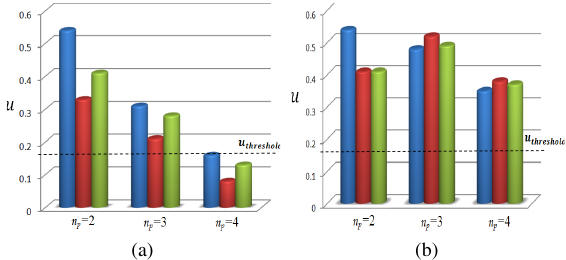
Figure 4: shows the uncertainty u variation against number of passages n p of a group of three adjacent cells in which change was detected. (a) represents the case of established changes while (b) represents the case of rapid or continuing changes. Figure 5: 3D ROC curve for neighborhood-1 (modified). Point A on the surface represents optimal/best results.